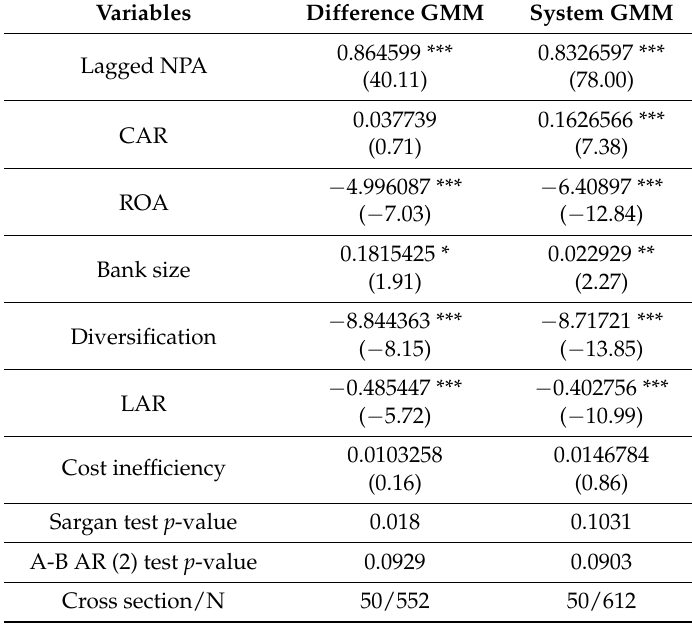
Table 4. Dynamic panel estimation results. Numbers in parentheses are z -statistics of respective